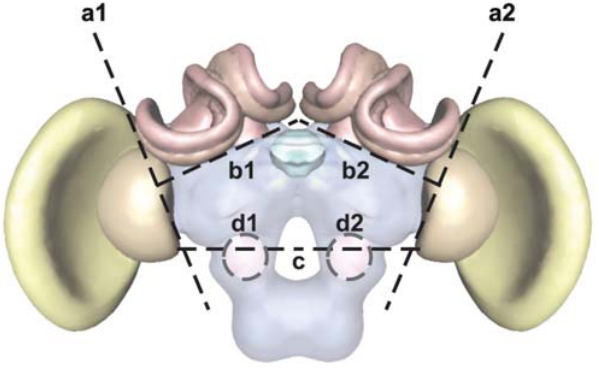
Figure 1. Schematic representation of brain with the regions that were used in the study. Dotted lines show the meridians of separation between the regions: a1 and a2–optic lobes, b1 and b2– mushroom bodies, c , d1 and d2 mark the lines along which the sub- esophageal ganglion and the antennal lobes were removed. Brain schema in Figure 1, 2, 3 and 5 drawn after